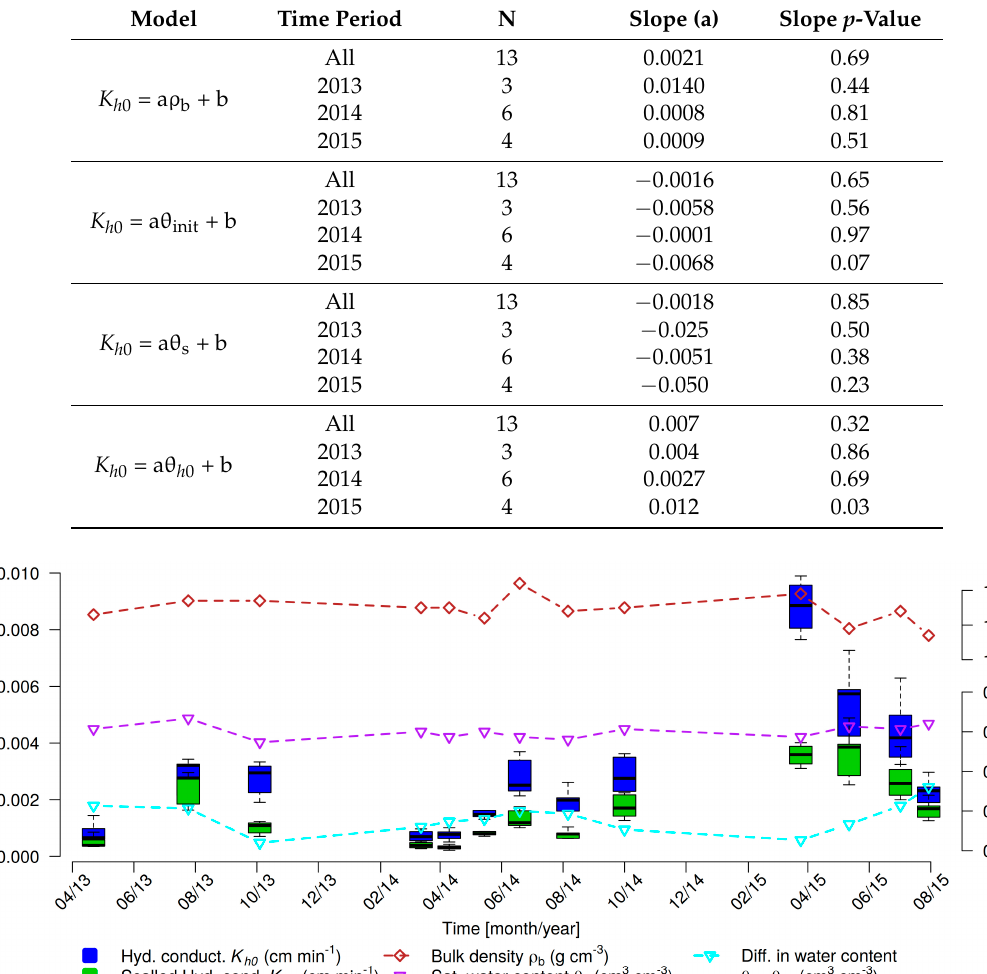
Table 2. t -test of the linear regressions assessing the relationship between unsaturated hydraulic conductivity at the − 3 cm pressure head ( K h 0 ) and bulk density ( ρ b ), initial water content ( θ init ), saturated water content ( θ s ) and water content under the pressure head of − 3 cm ( θ h0 ). N stands for number of data points, a for the slope and b for the interception.